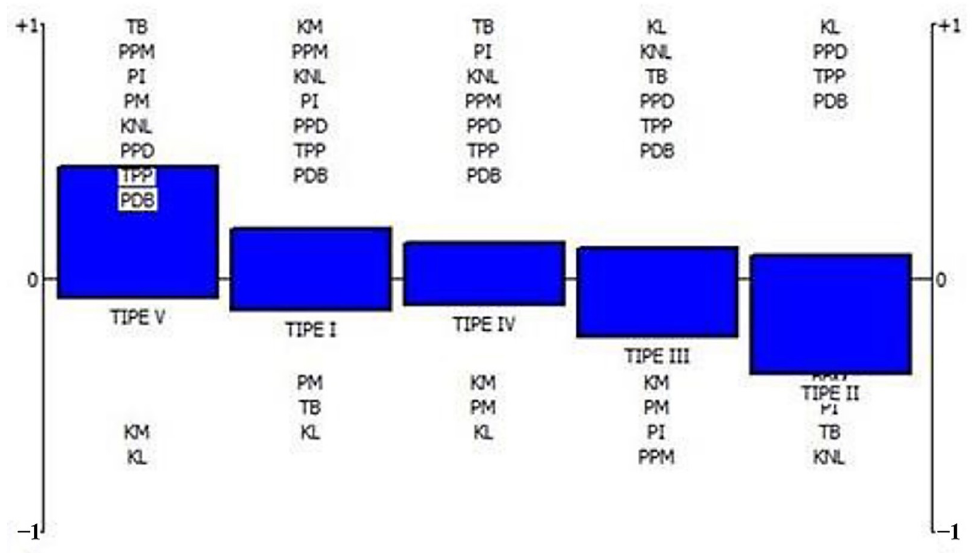
Figure 5. Promethee Rainbow for community-based village development strategy in Cigalontang District, Tasikmalaya Regency.